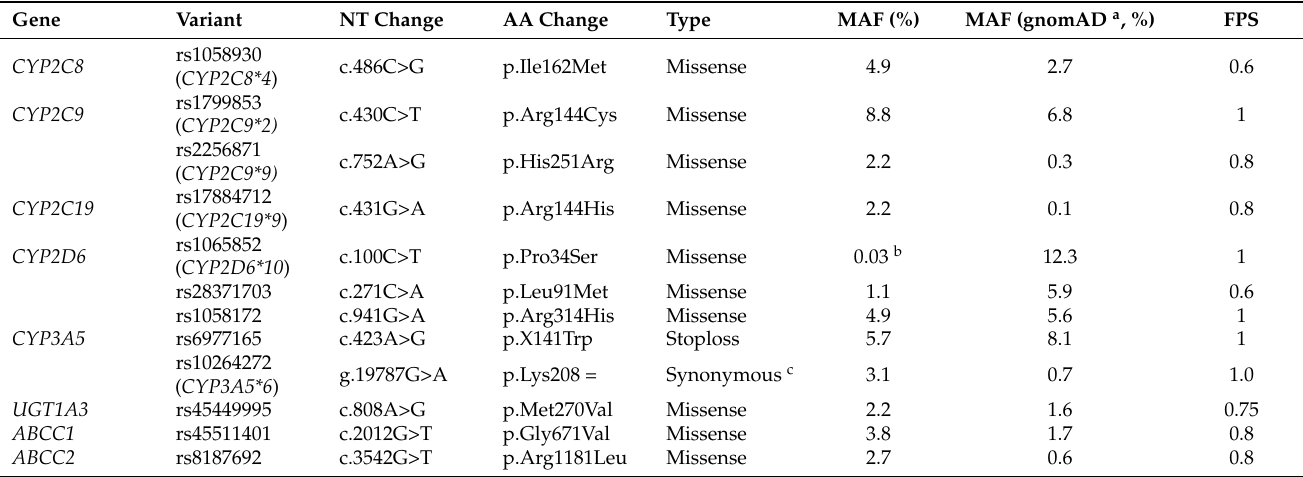
Table 3. Missense and stop-loss variants in PK-related genes (MAF > 1.0%) with deleterious function- ality prediction score (FPS >